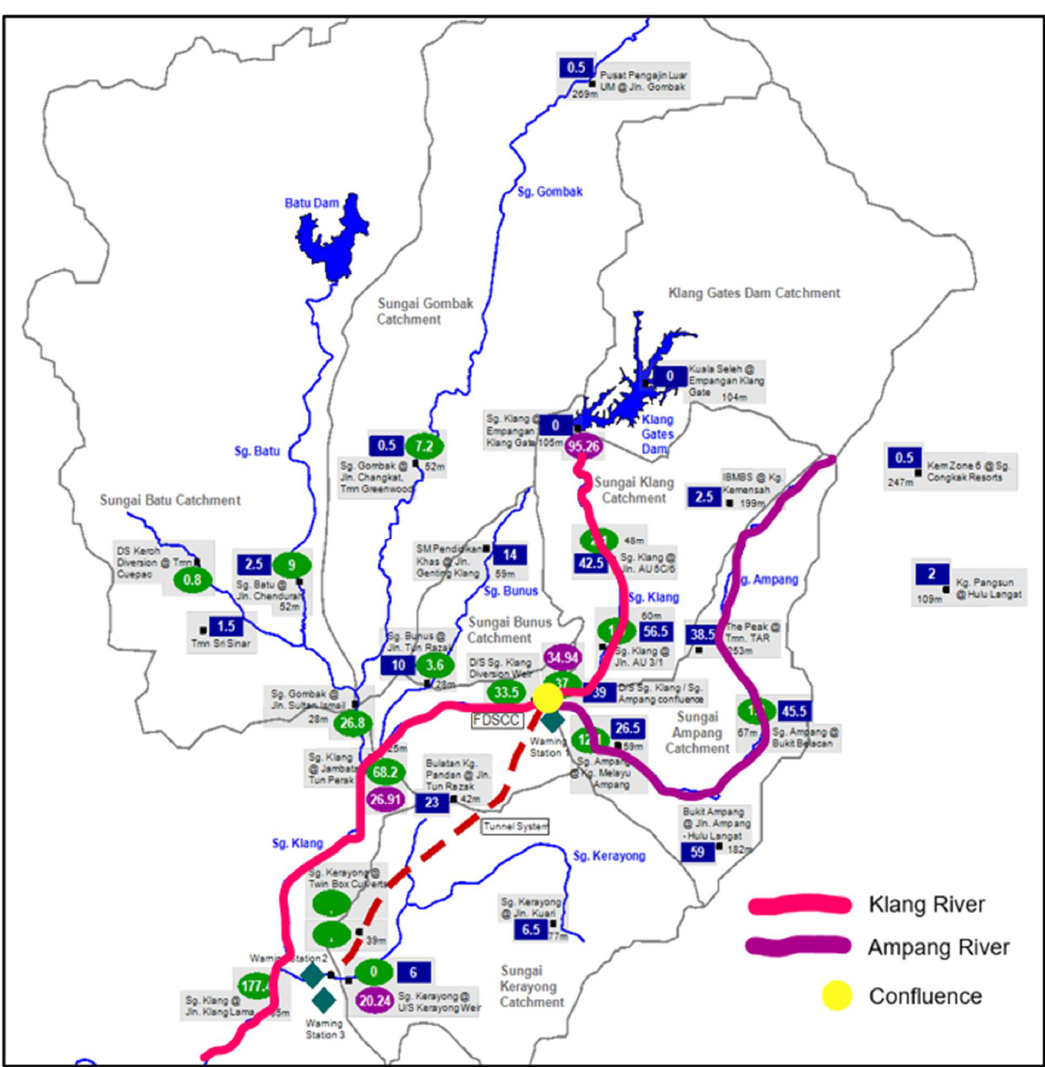
Figure 5. Map of study location at the Klang River Catchment.